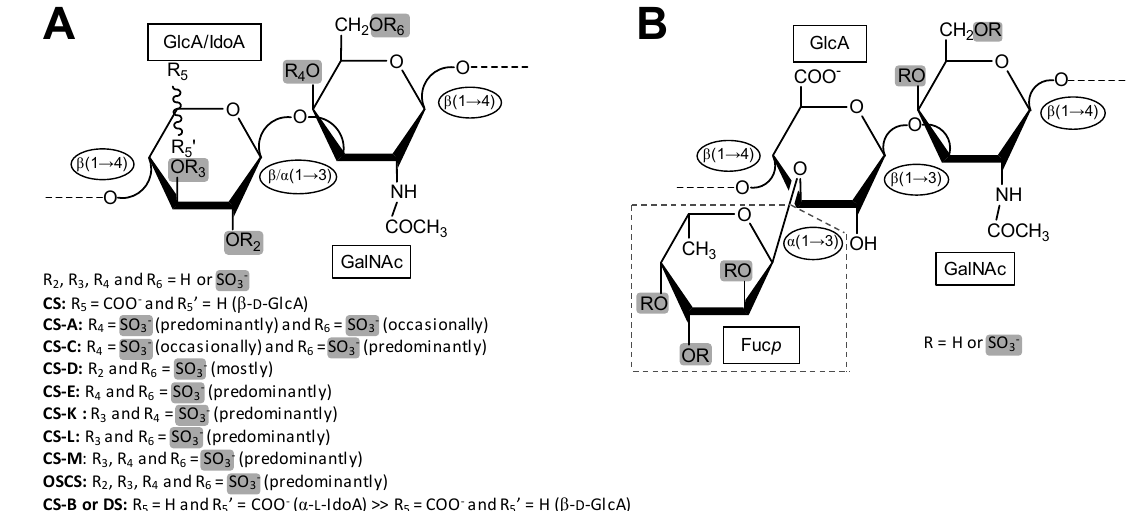
Figure 1. ( A ) Representative repeating disaccharide unit of chondroitin sulfate (CS) structures. CSs are composed of alternating 4-linked β - d -glucuronic acid (GlcA) and 3-linked β - d - N -acetylgalactosamine (GalNAc) units. While CS-A is mostly 4-sulfated at the GalNAc units, CS-C is predominantly 6-sulfated [7]. While CS-D is composed of 2-sulfated GlcA and 6-sulfated GalNAc, CS-E is composed of 4,6-di-sulfated GalNAc. CS-K, CS-L and CS-M are all sulfated at C3 position of GlcA, and respectively sulfated at positions C4, C6, and simultaneously at C4 and C6. Oversulfated chondroitin sulfate (OSCS) is fully sulfated. Dermatan sulfate (DS) also known as CS-B is composed of alternating 4-linked α -L-iduronic acid (IdoA) and 3-linked β - d -GalNAc units. ( B ) Representative repeating trisaccharide unit of the fucosylated chondroitin sulfate (FucCS). Besides consisting of the regular CS disaccharide unit as shown at panel A, the FucCS also exhibits branching units of α - l -fucopyranose (Fuc p ) 3-linked to the GlcA unit as highlighted with the box in dashed lines. The detailed structure of the Fuc p unit varies according to the holothurian species. In all panels the glycosidic bonds are indicated in ellipses whereas monosaccharide types are indicated in continuous black rectangles. For fast notation of the sulfation patterns, sulfation sites are highlighted by light-grey rectangles.